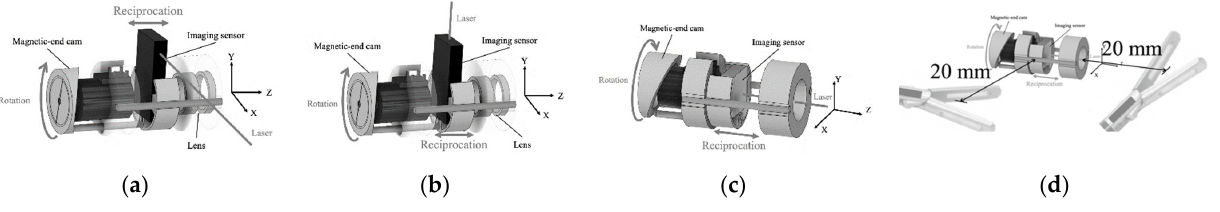
Figure 4. Accuracy of device motion was measured independently for the ( a ) x-axis, ( b ) y-axis, and ( c ) z-axis. The metal effect was measured with the dimensions shown in ( d ).